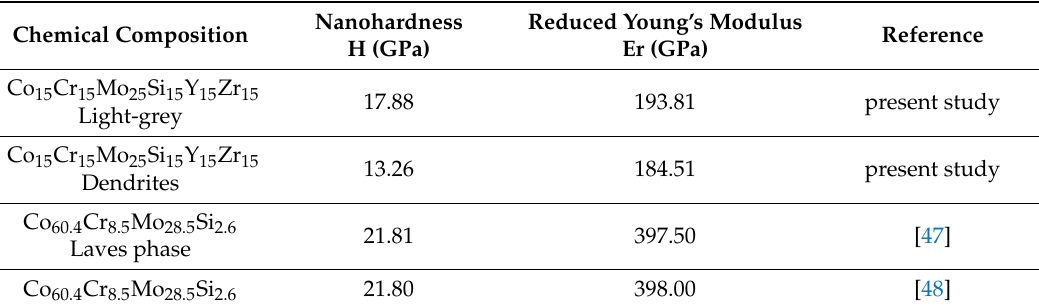
Table 5. Obtained nanohardness (H) and reduced Young’s modulus (Er) for the studied alloys in comparison to the literature-described high entropy alloy compositions.